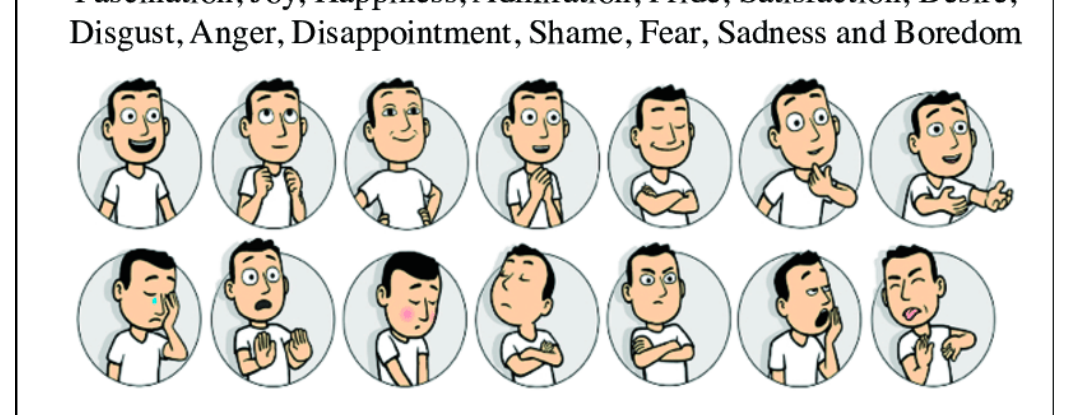
Figure 10. Emotion guideline [20].